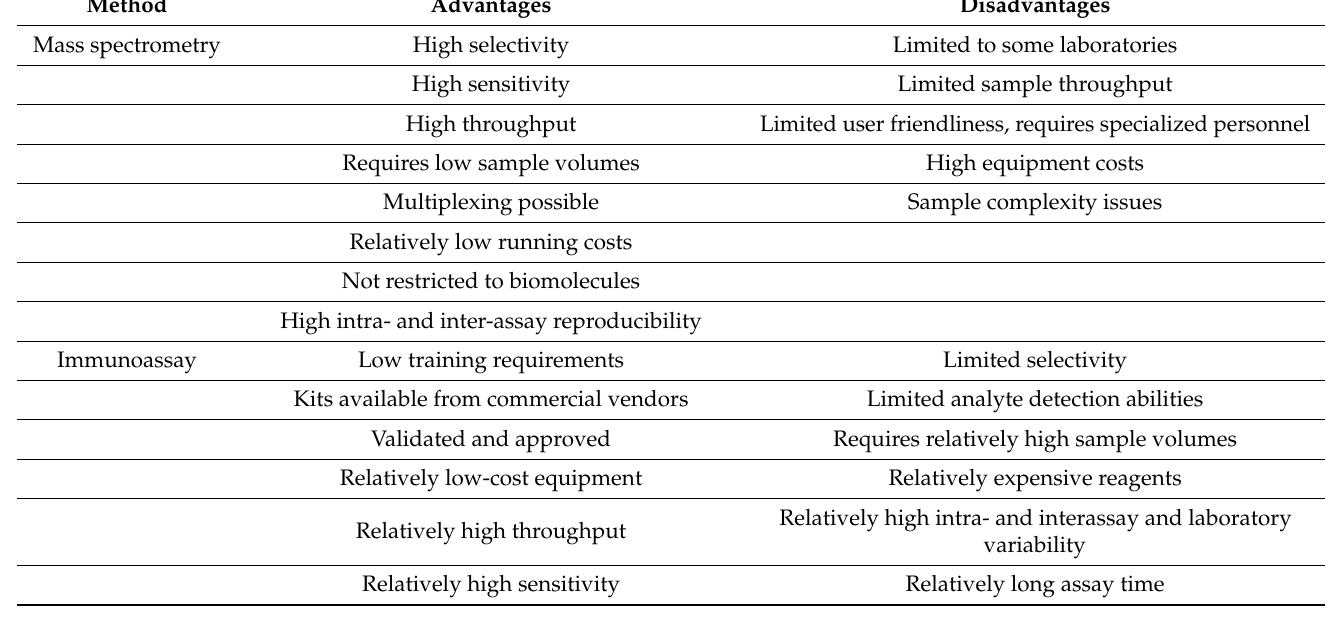
Table 1. Advantages and disadvantages of mass spectrometry-based assays and immunoassays [14].